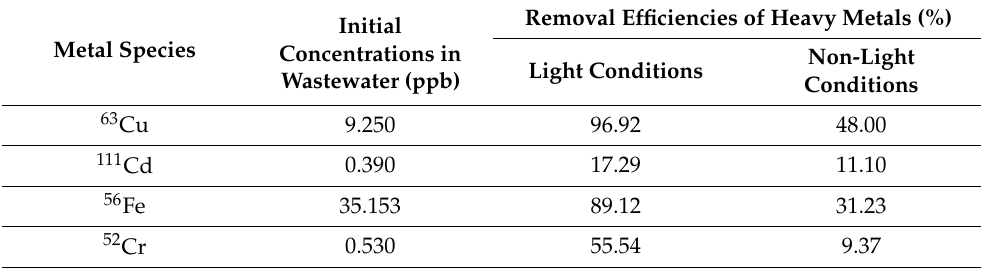
Table 3. Removal efficiencies of heavy metals from wastewater during LTNMg-based MFC operation for 168 h in the presence and absence of a light